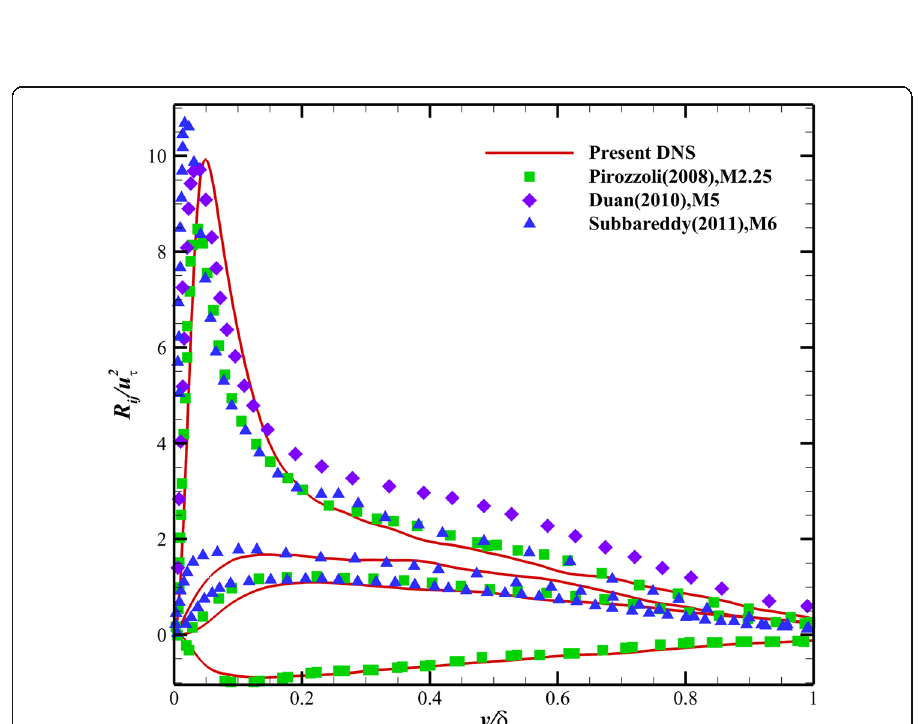
Fig. 4 Streamwise turbulent intensity normalized by Morkovin transformed